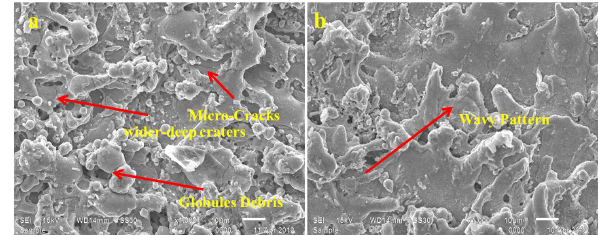
Figure 4: Surfaces have appeared with a wavy pattern, micro-cracks, wider-deep craters, globules of